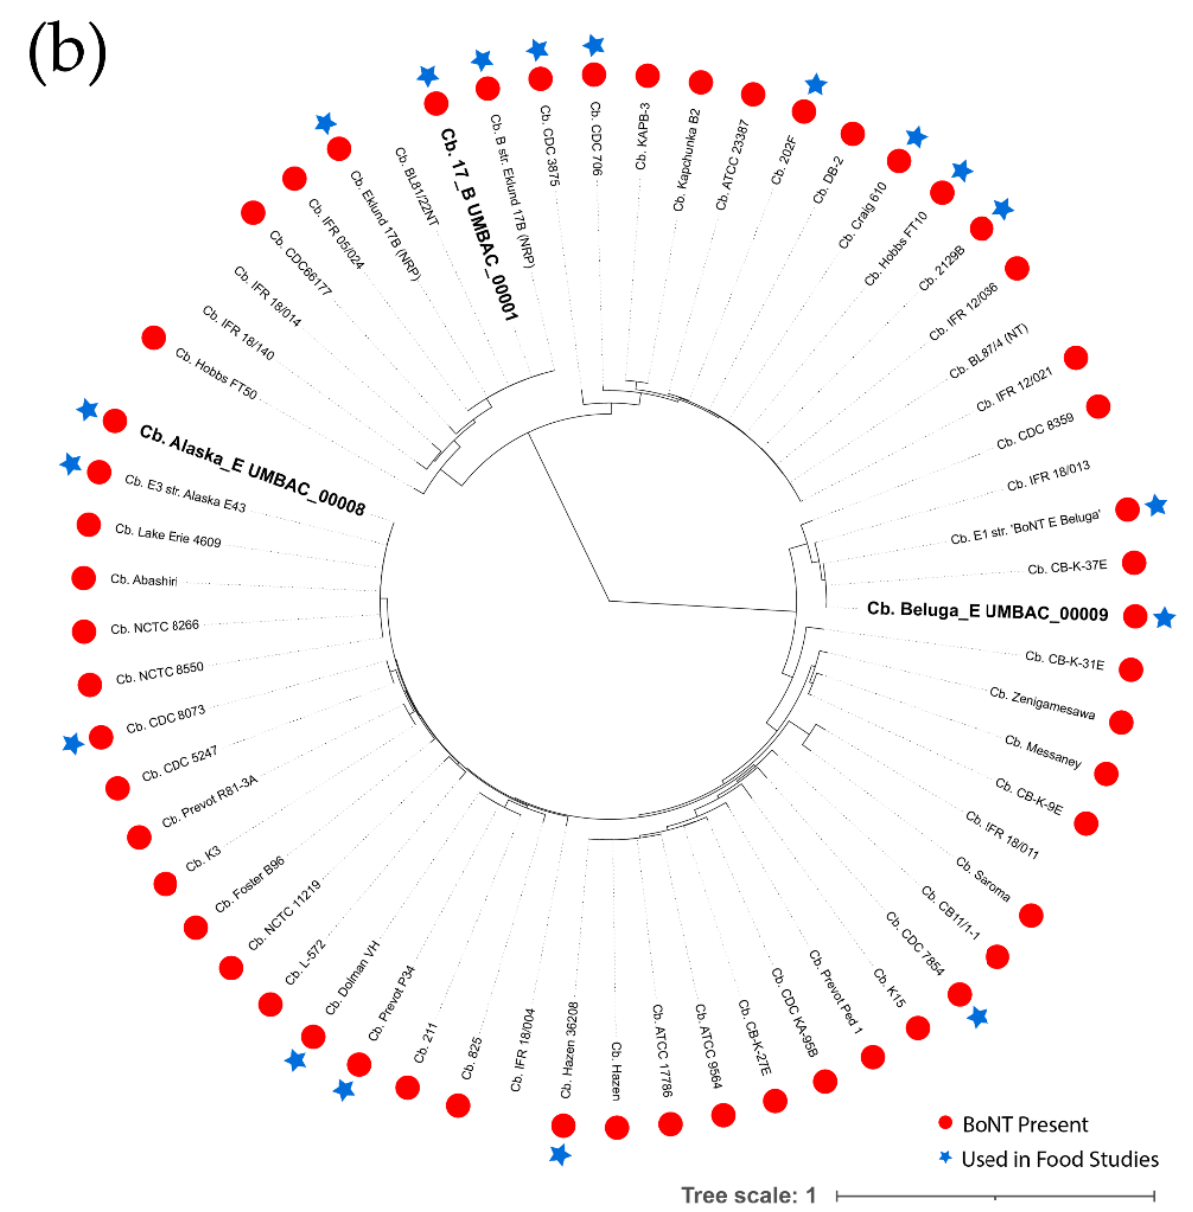
Figure 1. C. botulinum Group I/ C. sporogenes and C. botulinum Group II phylogenies. Core genome phylogenies demonstrating the relationship of sequenced cocktail strains (bold) relative to other strains of ( a ) Group I C. botulinum and C. sporogenes , and ( b ) Group II C. botulinum . The red dots indicate the presence of toxin gene clusters and the blue stars indicate strains commonly used in food safety studies. The grey checkmark in ( a ) denotes the presence of a CBO1751 gene homolog. 3.2. Several Group I and Group II C. botulinum Strains Display Antagonistic Growth Behavior Since strains within a cocktail may compete against each other, as indicated by the presence of a predicted lysin gene CBO1751 homolog in most Group I strains (Figure 1a) along with a recent report that strain Alaska E can produce a bactericidal lysin [39], we investigated potential inhibitory behavior between the strains of the 10-strain cocktail in a well diffusion assay. After 2 days, several clear zones indicative of inhibition between the test strains in the wells and the indicator lawn were observed (Table 2, Figure S1). All of the Group I strains except Okra B had clear zones of varying sizes surrounding their wells, indicating inhibition against at least one other strain in the cocktail. While the smaller